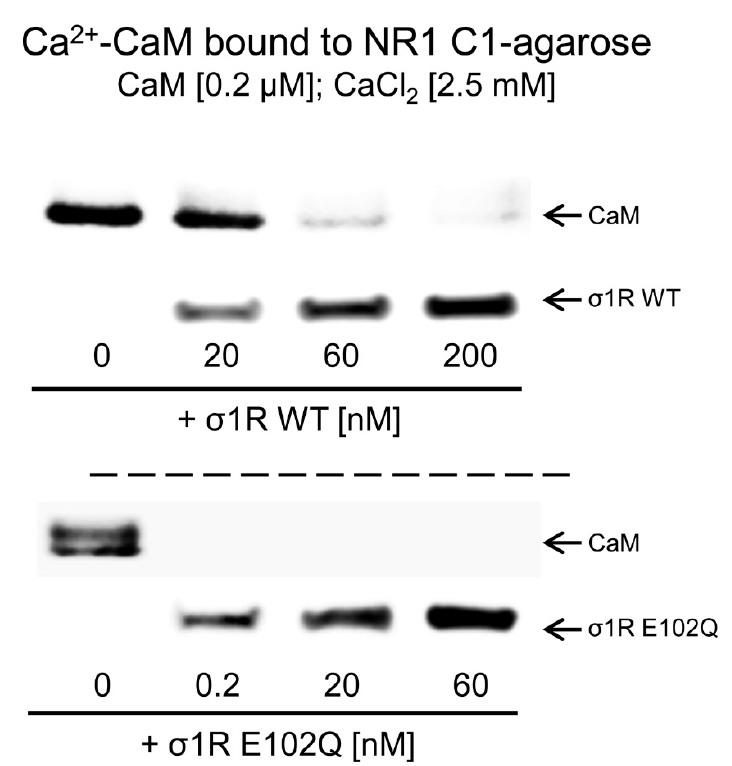
Figure 3. Competition analysis of σ 1R and CaM for binding to the NR1-C1 subunit of NMDARs. CaM (0.2 µ M) was incubated with the NR1-C1 subunit, which was covalently attached to NHS-activated Sepharose ® in the presence of 2.5 mM CaCl 2 and increasing concentrations of WT σ 1R or the human σ 1R E102Q mutant. After incubation, CaM and σ 1R that remained bound to the NR1-C1 subunit were isolated, resolved by SDS-PAGE and analyzed by western blotting. The assays were repeated at least twice, and comparable results were obtained. Representative blots are shown. CaM, calmodulin; σ 1R, sigma receptor type 1; WT,